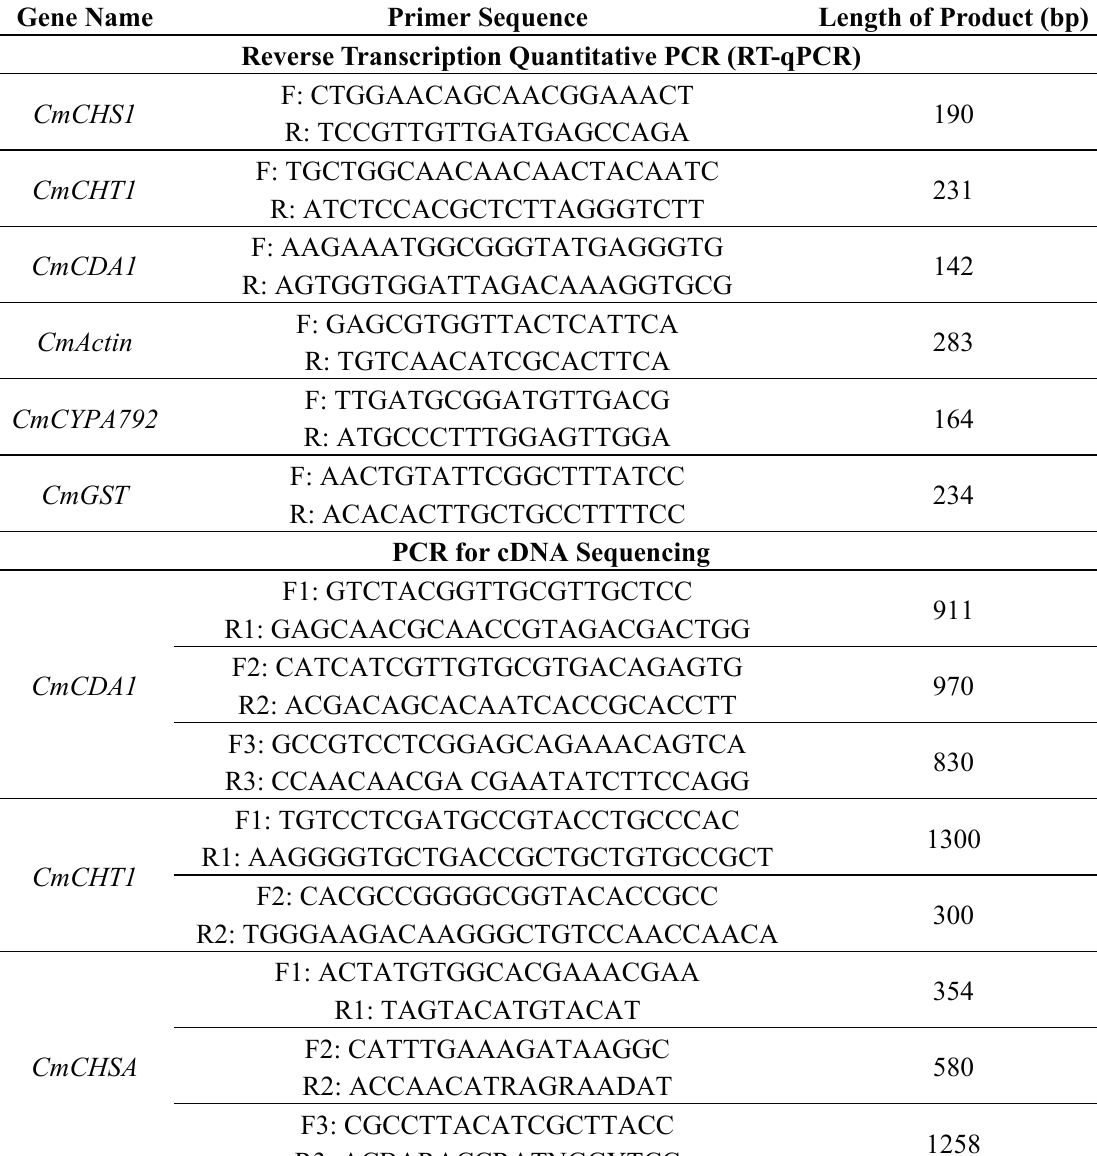
Table 4. Primers used in sequencing the full-length cDNA and reverse transcription quantitative PCR (RT-qPCR)